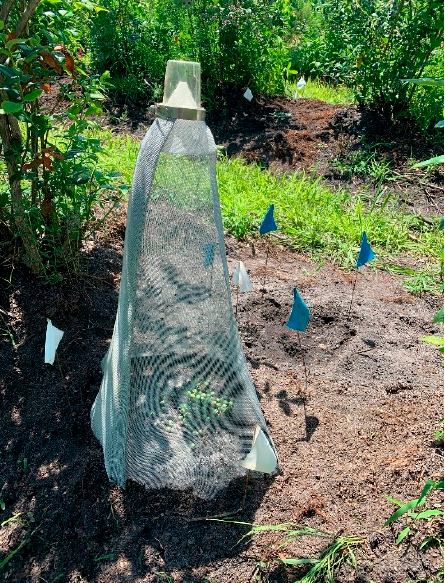
Figure 1. Pyramidal emergence cage (43.7 cm diameter base; 64 cm tall) made of aluminum window screen and a boll weevil trap fitted with a stainless-steel hose clamp at the top (lower left) and arenas (30 × 30 cm) for the determination of entomopathogenic nematode persistence (upper right). Treatments were a water-only control, S. scarabaei , S. riobrave , S. feltiae , and S.